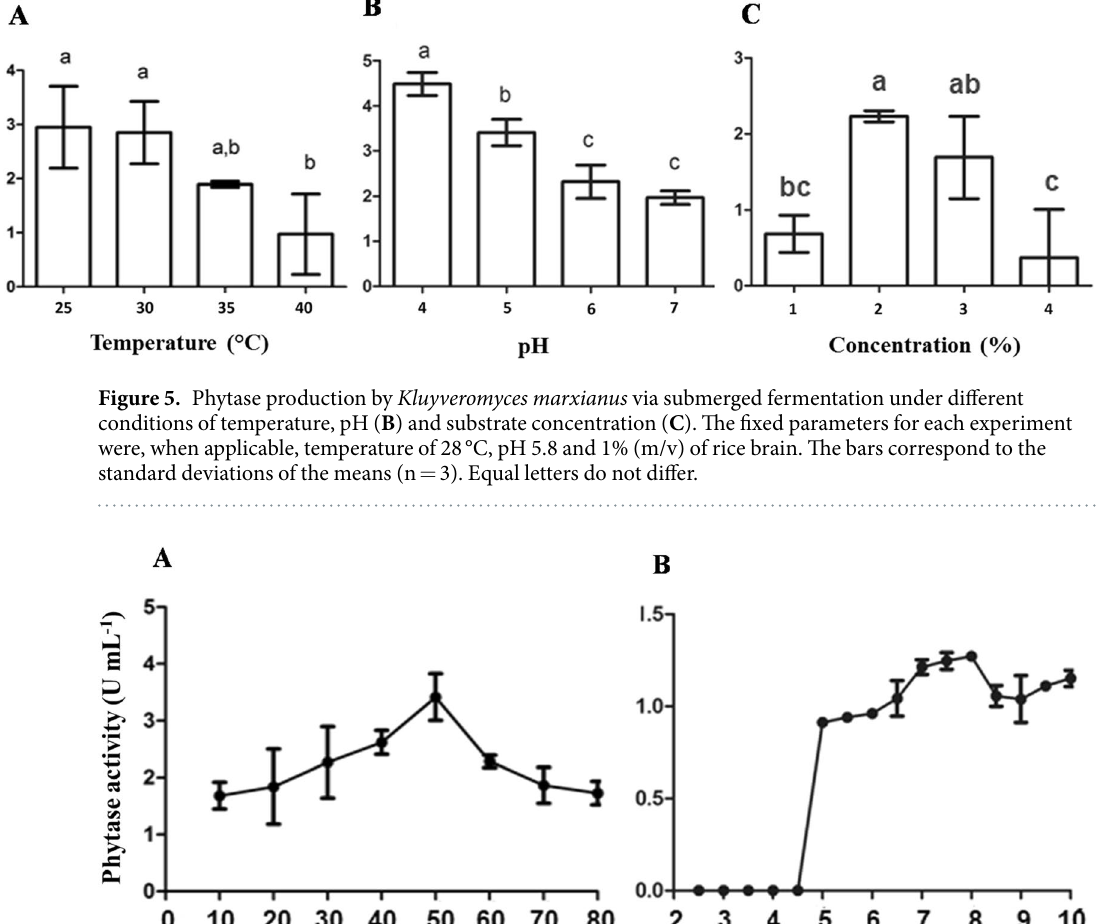
On the other hand, the extract obtained from K. marxianus presented peaks of maximum activity of phytase at 60 and 80 °C. Besides, it was stable throughout the pH range tested (2.5 to 10.0). The highest activity was obtained at pH 4.0 and the smallest, close to the neutral pH (Fig. 7).